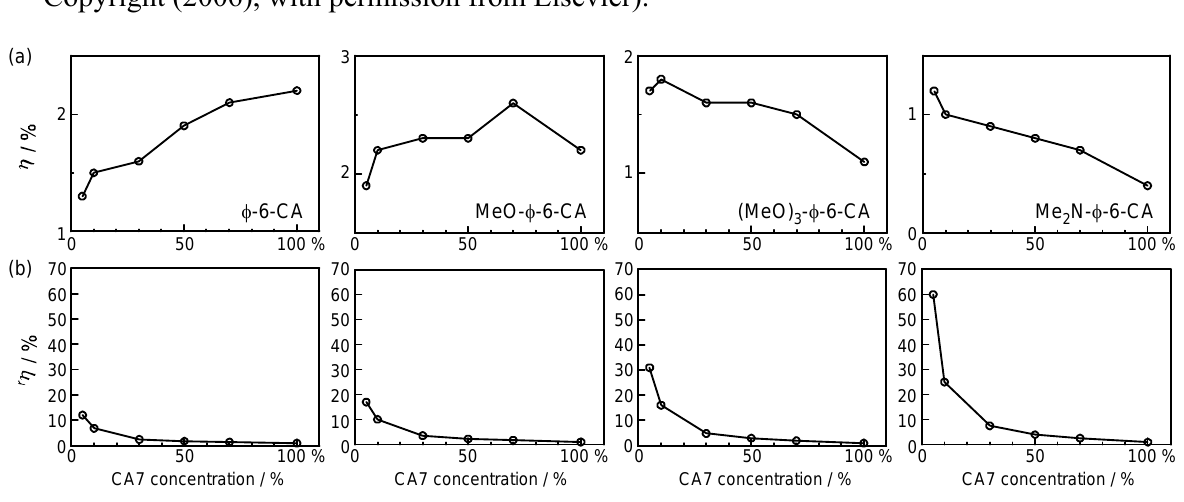
Figure 17. Concentration dependence of (a) the conversion efficiency ( η ), and (b) the relative conversion efficiency ( r η ) in solar cells using the four sensitizers with increasing polarizabilities. See the caption of Figure 13 for the definition of r η (reprinted from [15], Copyright (2006), with permission from